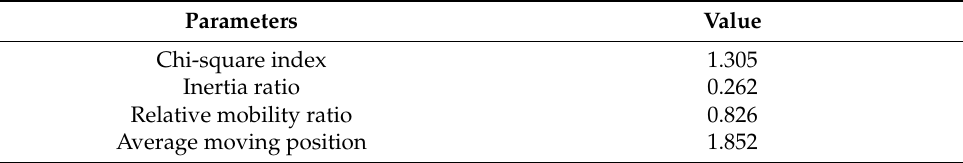
Table 4. Value of relative mobility